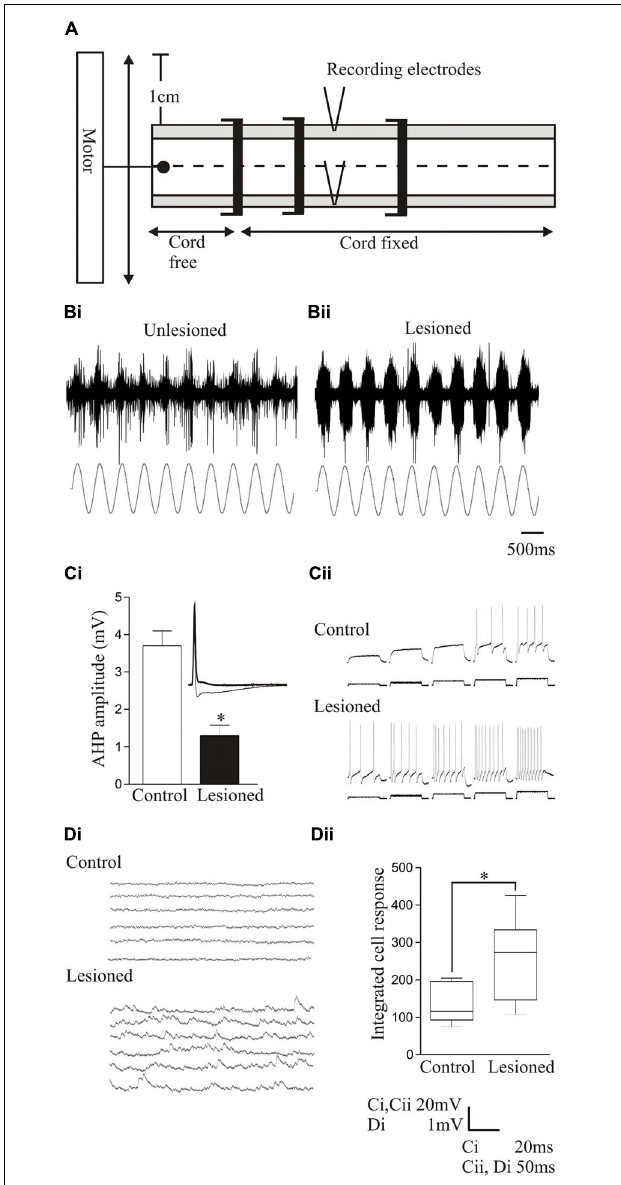
FIGURE 6 | Changes in sensory feedback after lesioning. (A) Diagram showing the experimental procedure for evoking and monitoring proprioceptive feedback to the spinal cord. The spinal cord is fixed except at a free end that is attached to a computer-driven motor that imposes sinusoidal movements of the cord. Movement-dependent activity is recorded from the lateral tract where edge cell axons run. Stretch-evoked responses to a 1 Hz bending command in an unlesioned (Bi) and lesioned spinal cord (Bii) . (Ci) Graph showing the significant reduction of the post-spike slow afterhyperpolarization (sAHP) in an edge cell in a lesioned spinal cord. The inset shows an edge cell action potential in an unlesioned and lesioned spinal cord (thick line). (Cii) Traces showing the increase in edge cell excitability in response to depolarizing current injection in the unlesioned and lesioned spinal cord. (Di) Traces showing spontaneous synaptic inputs in an edge cell in an unlesioned and lesioned spinal cord. (Dii) Graph showing the significant increase in the integrated spontaneous synaptic input in edge cells after lesioning. Data from Hoffman and Parker (2011). Permission granted to reproduce. ∗ Indicates statistical significance at p <